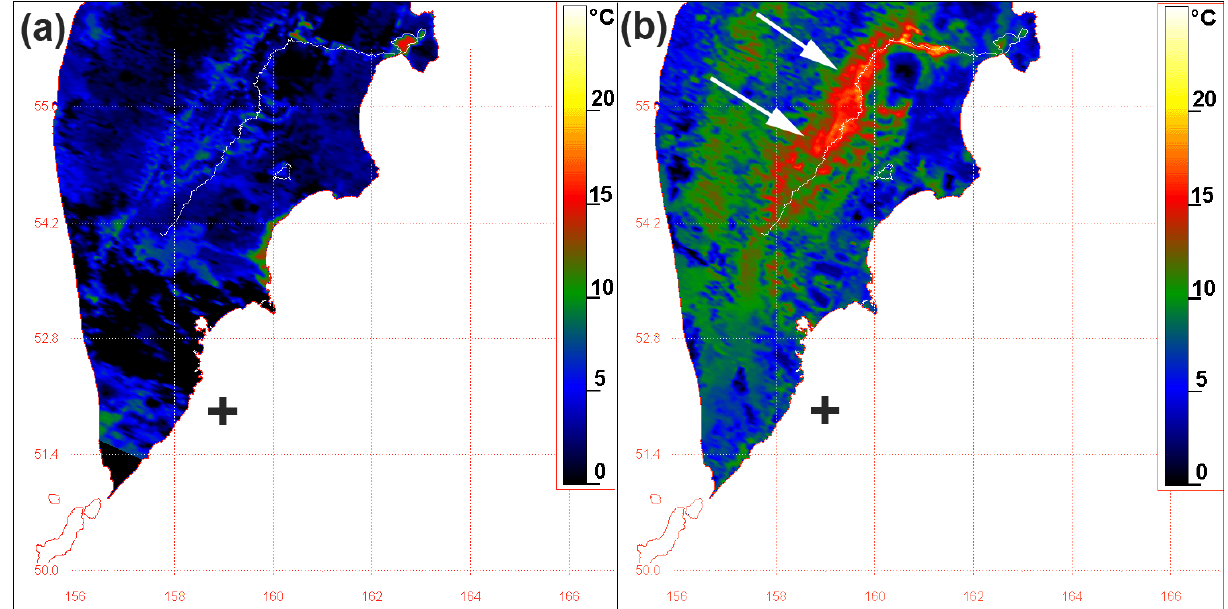
Figure 13. Thermal anomaly related with Kamchatka earthquake (M = 7.0, 21 Jun 1996, Far East, Russia). (a) Background situation, satellite NOAA-14, 14 Jun 1996, cross-earthquake epicenter 21 Jun 1996. (b) Thermal anomaly, satellite NOAA-14, 22 Jun 1996, arrows show thermal anomaly, cross-earthquake epicenter